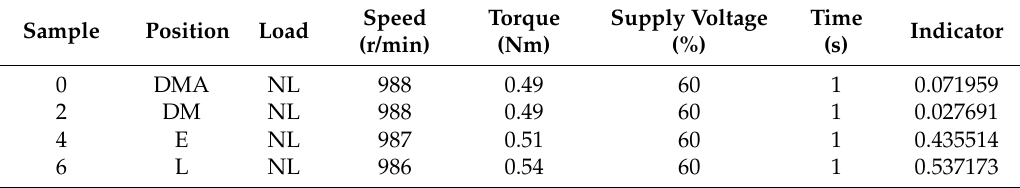
Table 11. Results of the indicator in the time domain, based on Equations (6)–(8), for the data of the experiments with the motor with one broken bar during startup.